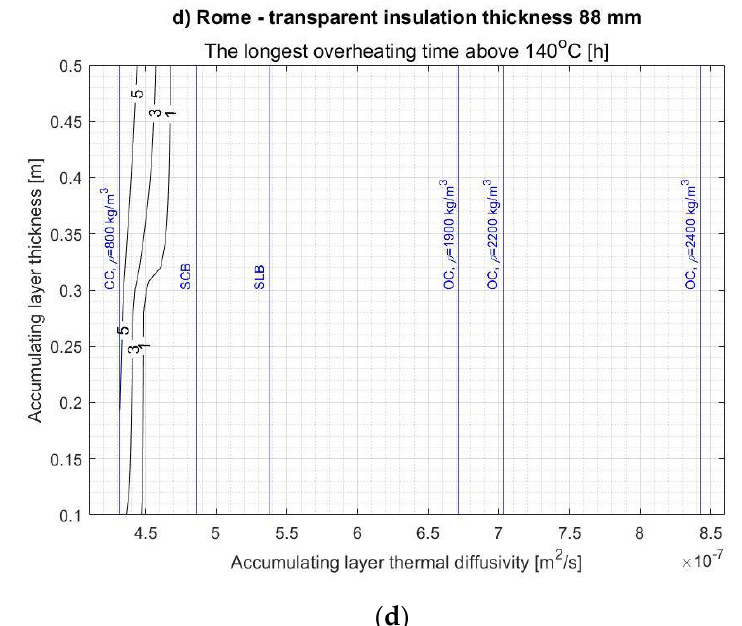
Figure A11. Contour graphs characterizing the SW basic parameters in a function of AL thermal diffusivity and thickness for the whole heating season: ( a ) the heat balance of the SW’s unit area, ( b ) the heating time, ( c ) the mean time lag of the maximum temperature on the absorber and SW’s internal surface during the day, ( d ) the longest overheating time above 140 °C in the TI. TI thickness: 88 mm. Location: Rome.